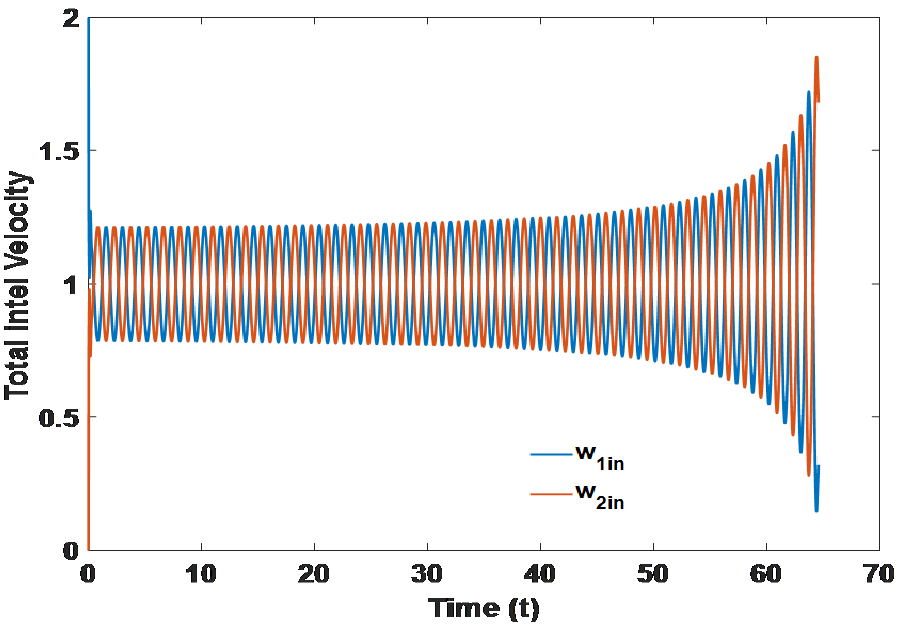
Figure 13. Existence of subcritical Hopf bifurcation.